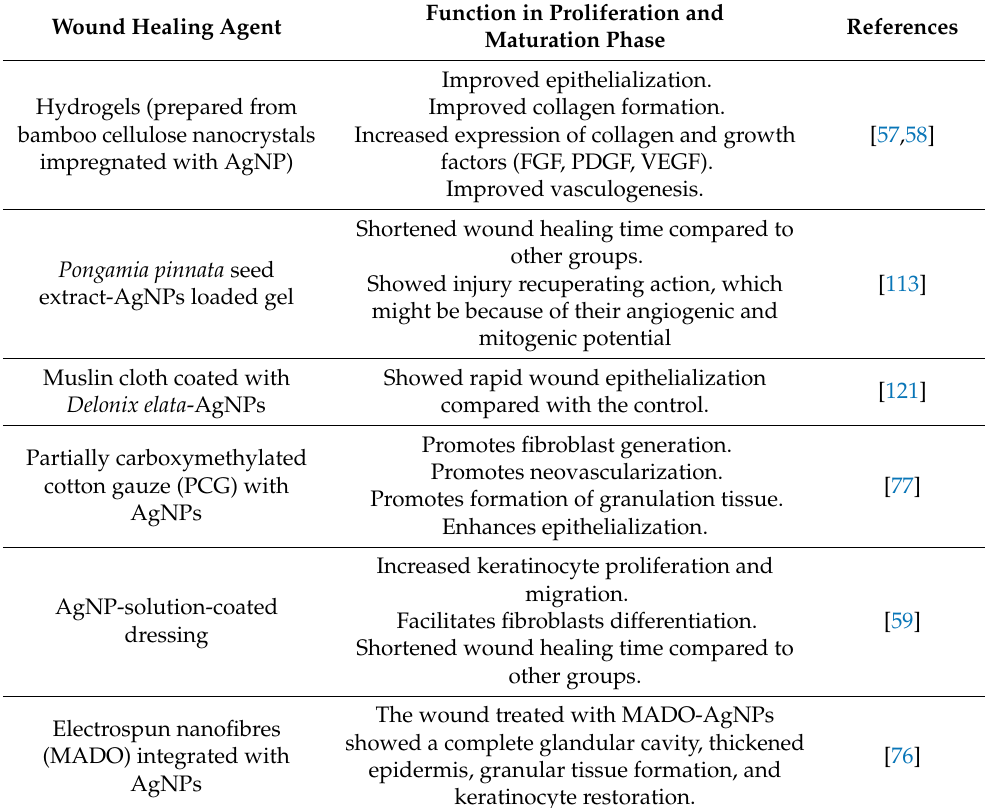
Table 2. Silver based wound healing agents reported to enhance the proliferation phase of wound healing.